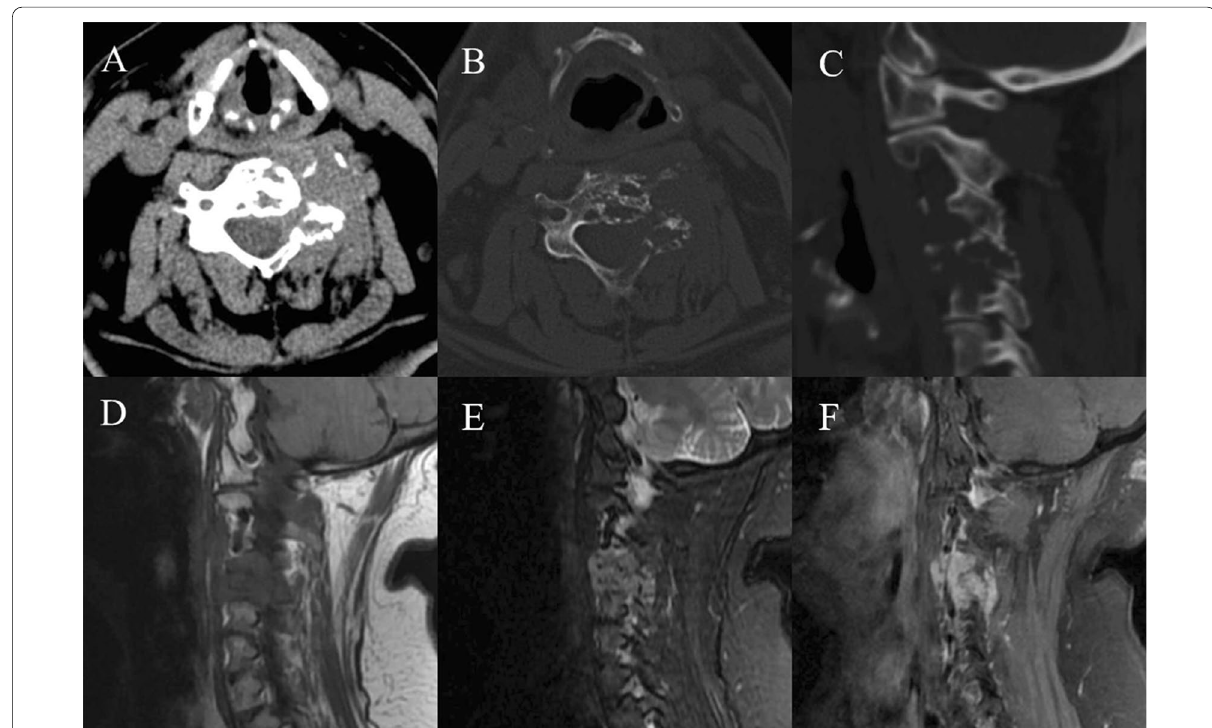
Fig. 1 A 73-year-old female with C4 primary leiomyosarcoma. A Axial computed tomography (CT) showed an ill-defined isodense mass in the vertebral body and posterior elements of C4; B axial CT bone window showed osteolytic bone destruction, with residual bone trabeculae; C sagittal CT bone window showed osteolytic bone destruction; D T1 weighted imaging (T1WI) in sagittal view showed an isointense mass; E T2 weighted imaging (T2WI) in sagittal view showed an isointense mass; F Magnetic resonance imaging (MRI) enhanced scanning showed